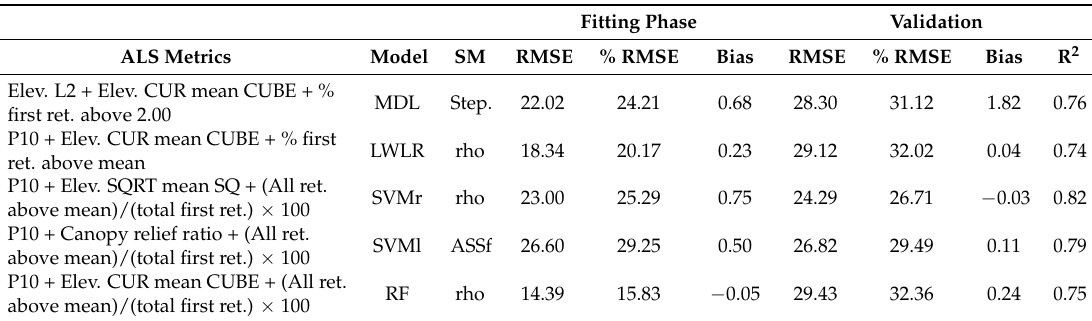
Table A14. Summary of the W models using 2011 ALS data. Validation results in terms of RMSE (tons ha − 1 ), %RMSE, and bias (tons ha − 1 ) and R 2 . SM refers to selection method; Step. stands for Stepwise both and forward; SVMr. refers to support vector machine with radial kernel; SVM l. refers to support vector machine with linear kernel; ret. refers to returns.